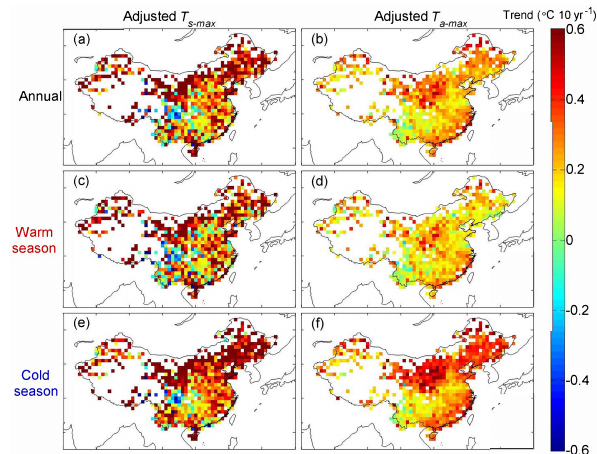
Figure 7. Regional average anomalies of daily maximum land sur- face temperature ( T s-max , blue line) and daily maximum air tem- perature ( T a-max , red line) for the annual (a) , warm (b) , and cold (c) seasonal scales for the reference period from 1961 to 1990. We used Eq. (1) to simultaneously adjust for the effects of surface so- lar radiation ( R s ) and precipitation ( P) on T s-max and T a-max and then analyzed the changes in the interannual variation of T s-max and T a-max (Sect. 3.3).